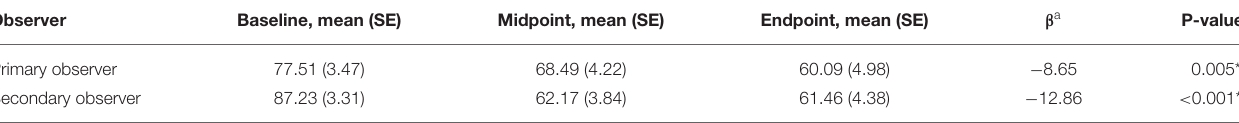
TABLE 9 | Children’s mental health